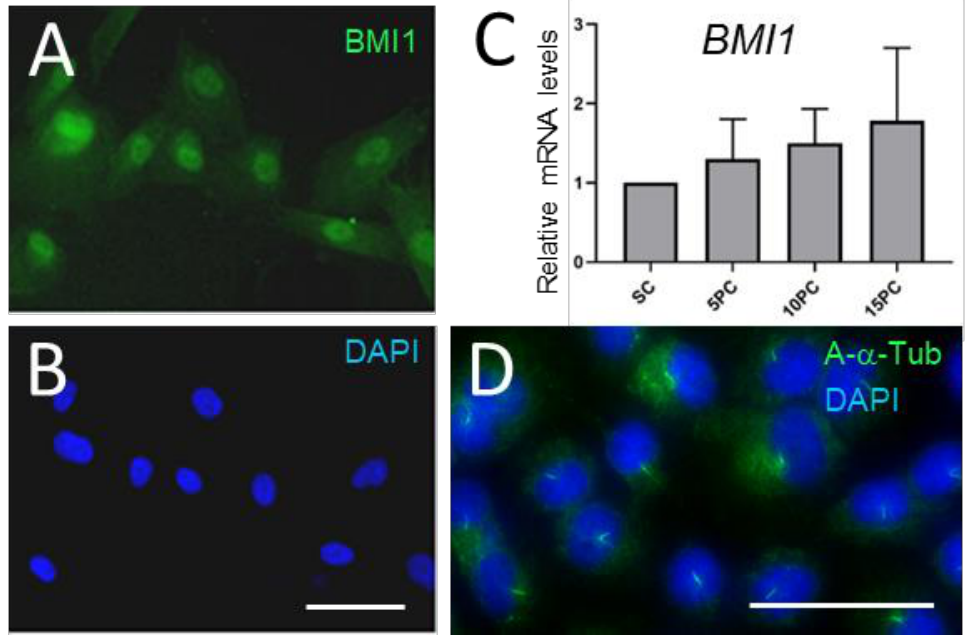
Figure 10. Constitutive expression of BMI1 and assembly of the primary cilia in HIEC-6 cells. ( A , B ): Representative immunodetection of BMI1 ( A ) and DAPI nuclear co-staining ( B ) in newly confluent HIEC cells. ( C ): BMI1 transcript expression in subconfluent (SC) and 5-, 10- and 15-day post-confluent (5PC, 10PC and 15PC) HIEC-6 cells. ( D ): Immunodetection of acetylated- α -tubulin (A- α -tub) in newly confluent HIEC-6 (green) cells. Scale bars are equal to 25 µ